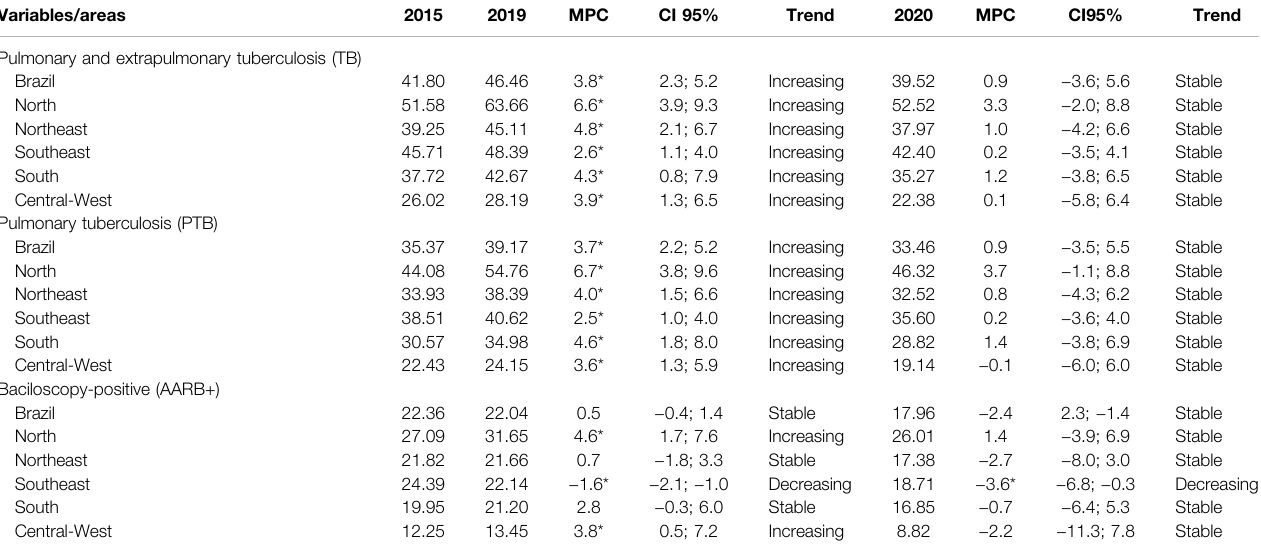
TABLE 1 | Temporal trends of tuberculosis detection coef fi cient (per 100,000 inhabitants) in Brazil and its regions between 2015 and 2020.